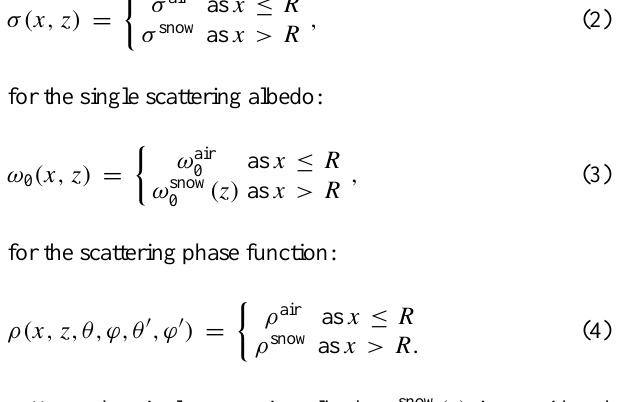
The function I(x, z,θ,ϕ) depends on the spatial coordi- nates x, z and angles θ , φ , defining direction (cid:127) of the radi- ation transfer, see Fig. 2. The first term in Eq. (1) gives the change of intensity in the direction (cid:127) and the second term represents the extinction of radiation by the medium. The in- Reflecting surface with albedo A ( x ) tegral describes the re-radiation of scattered light, here inci- Fig. 2 dent light has the direction (cid:127) 0 (θ 0 , ϕ 0 ) and re-radiated light has the direction (cid:127) (θ, ϕ) . The pit [ 0 , R ] × [ 0 , H ] , R = D/ 2, is filled by air, whereas the medium out of the pit is snow. Then it follows that for the extinction coefficient: